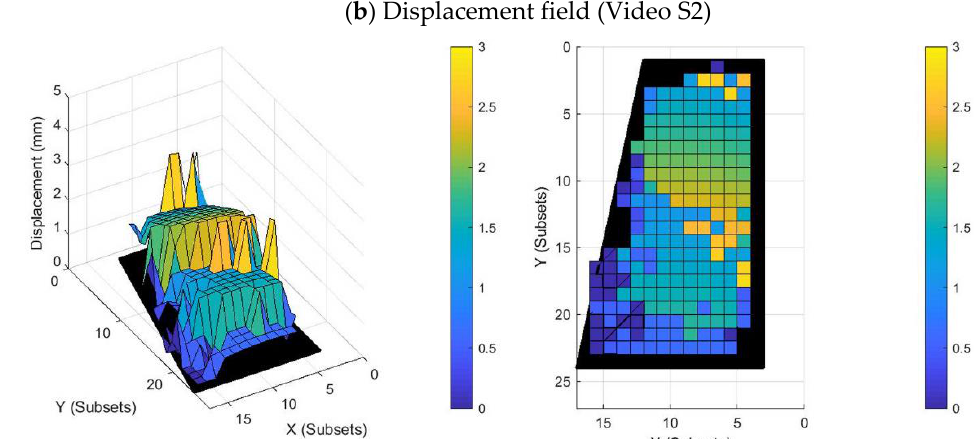
Figure 9. Screenshots of supplementary videos: ( a ) raw data acquisition (Video S1) and ( b ) the displacement field corresponding to the post‑processing of raw data from two different perspective points (Video S2). The color bars represent the displacement field (mm).